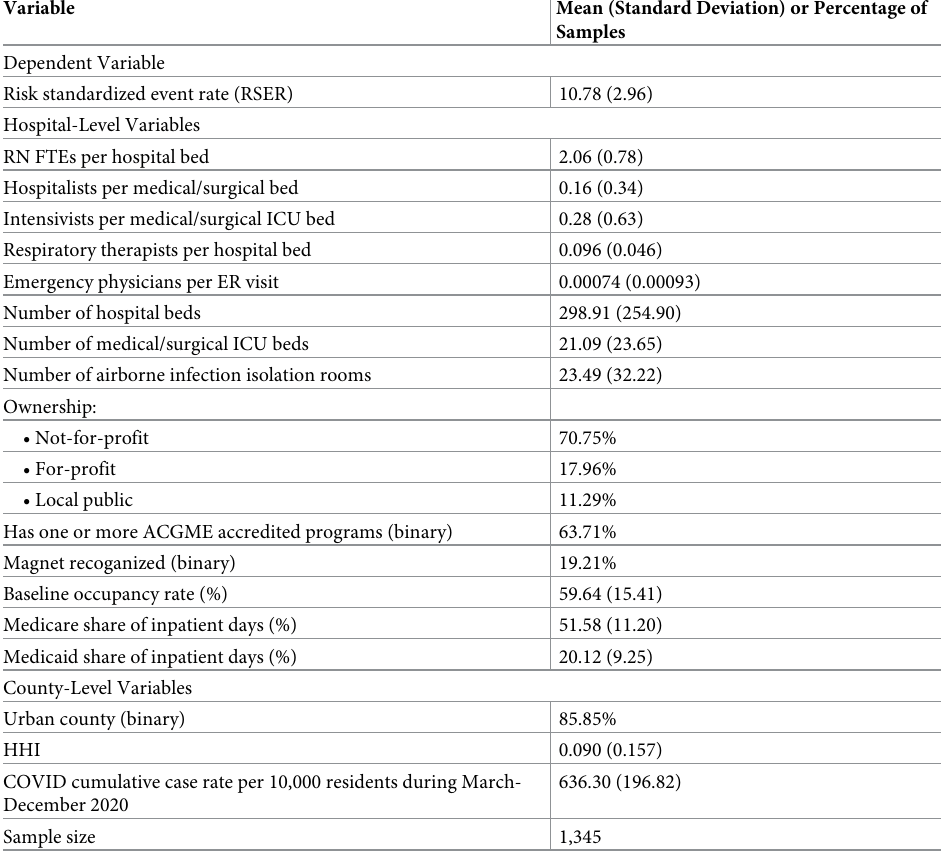
Table 1. Summary statistics of hospital and county level